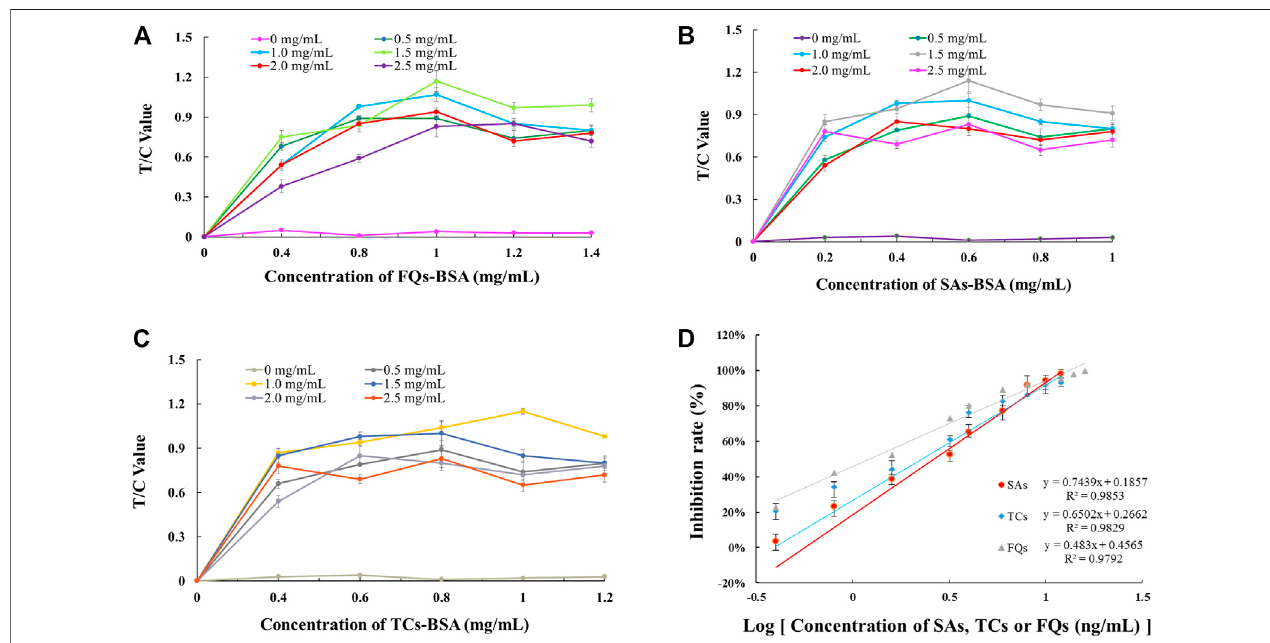
FIGURE3| Parameteroptimisationofsingle-EuNPs-FIA. (A) EffectofencapsulationconcentrationsofFQs-BSAandGAM-IgGonthedetectioncapacityofsingle- EuNPs-FIA. (B) Effect of encapsulation concentrations of SAs-BSA and GAM-IgG on the detection capacity of single-EuNPs-FIA. (C) Effect of encapsulation concentrations of TCs-BSA and GAM-IgG on the detection capacity of single-EuNPs-FIA. (D) Three standard curves for single-EuNPs-FIA.